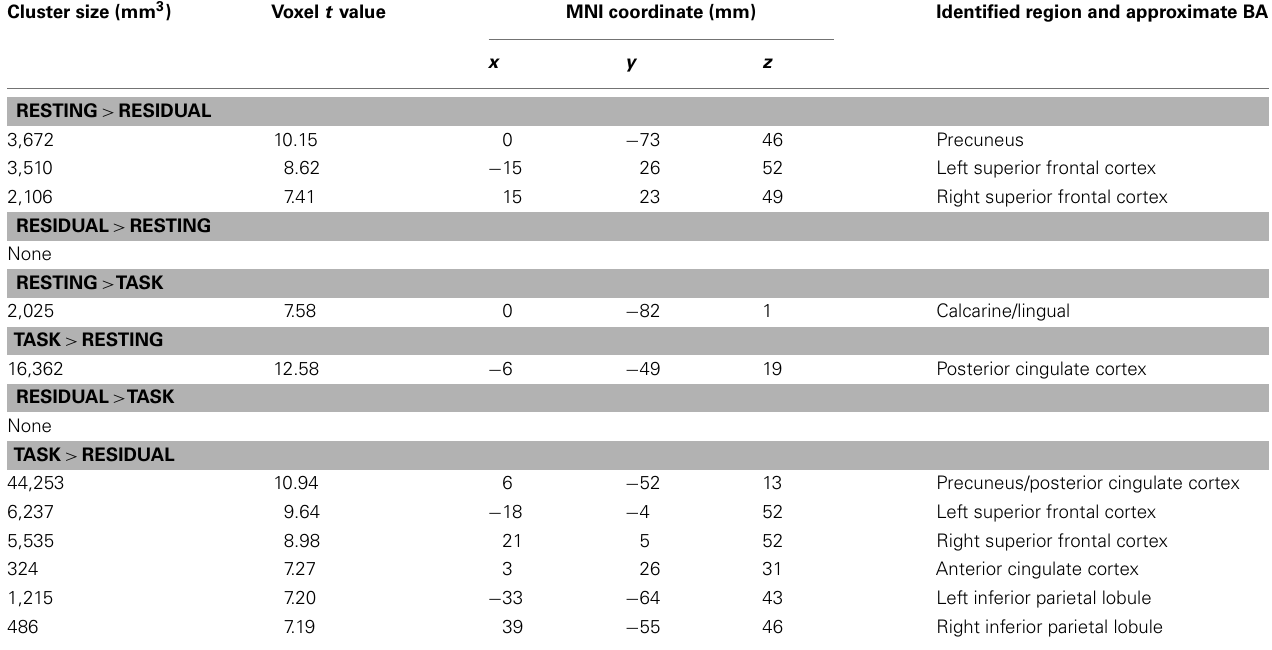
Table 2 | Regional brain activations of default network during resting compared to residual, during resting compared to task, and during residual compared to